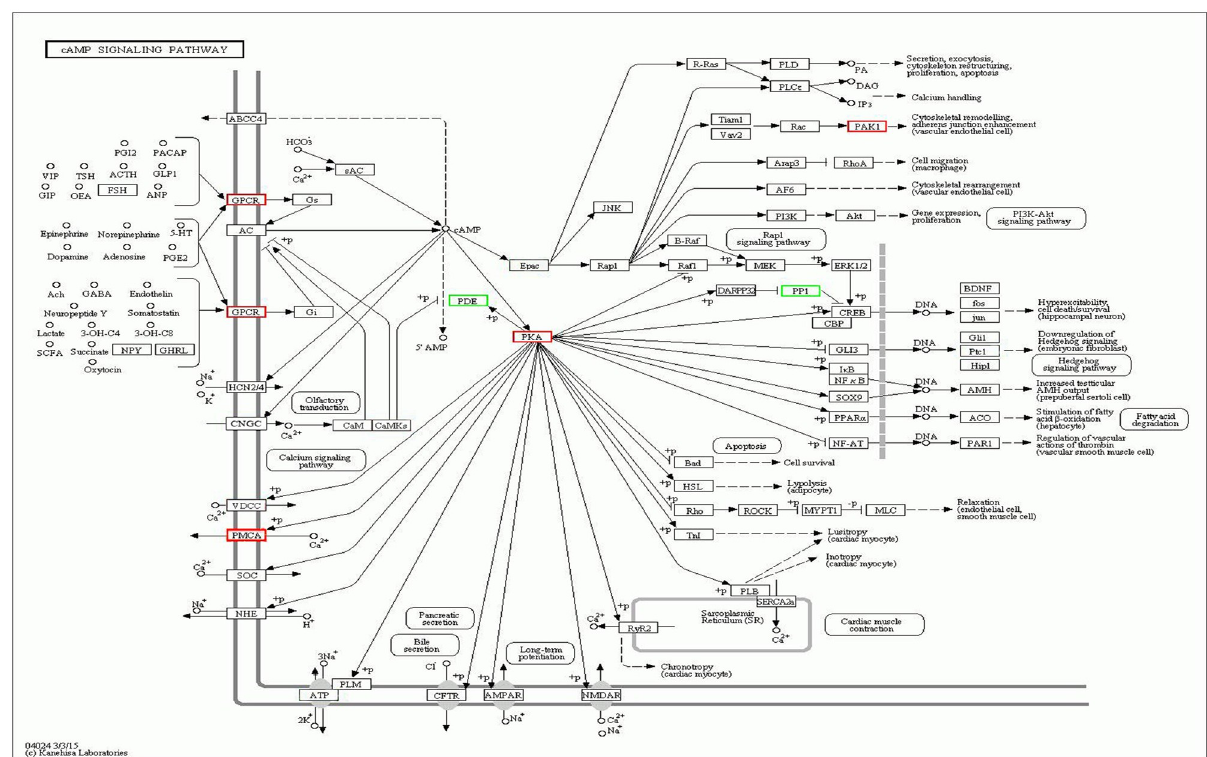
Fig 4. Up- and down-regulated DEGs in the adenosine 3’,5’-cyclic monophosphate (cAMP) signaling pathway (map04024) between female control versus female DXM treated (FcVSFt). Red boxes indicate upregulated genes in DXM-treated female worms. Green boxes indicate downregulated genes in DXM-treated female worms. (KEGG database network diagram; KEGG website; https://www.genome.jp/dbget-bin/www_